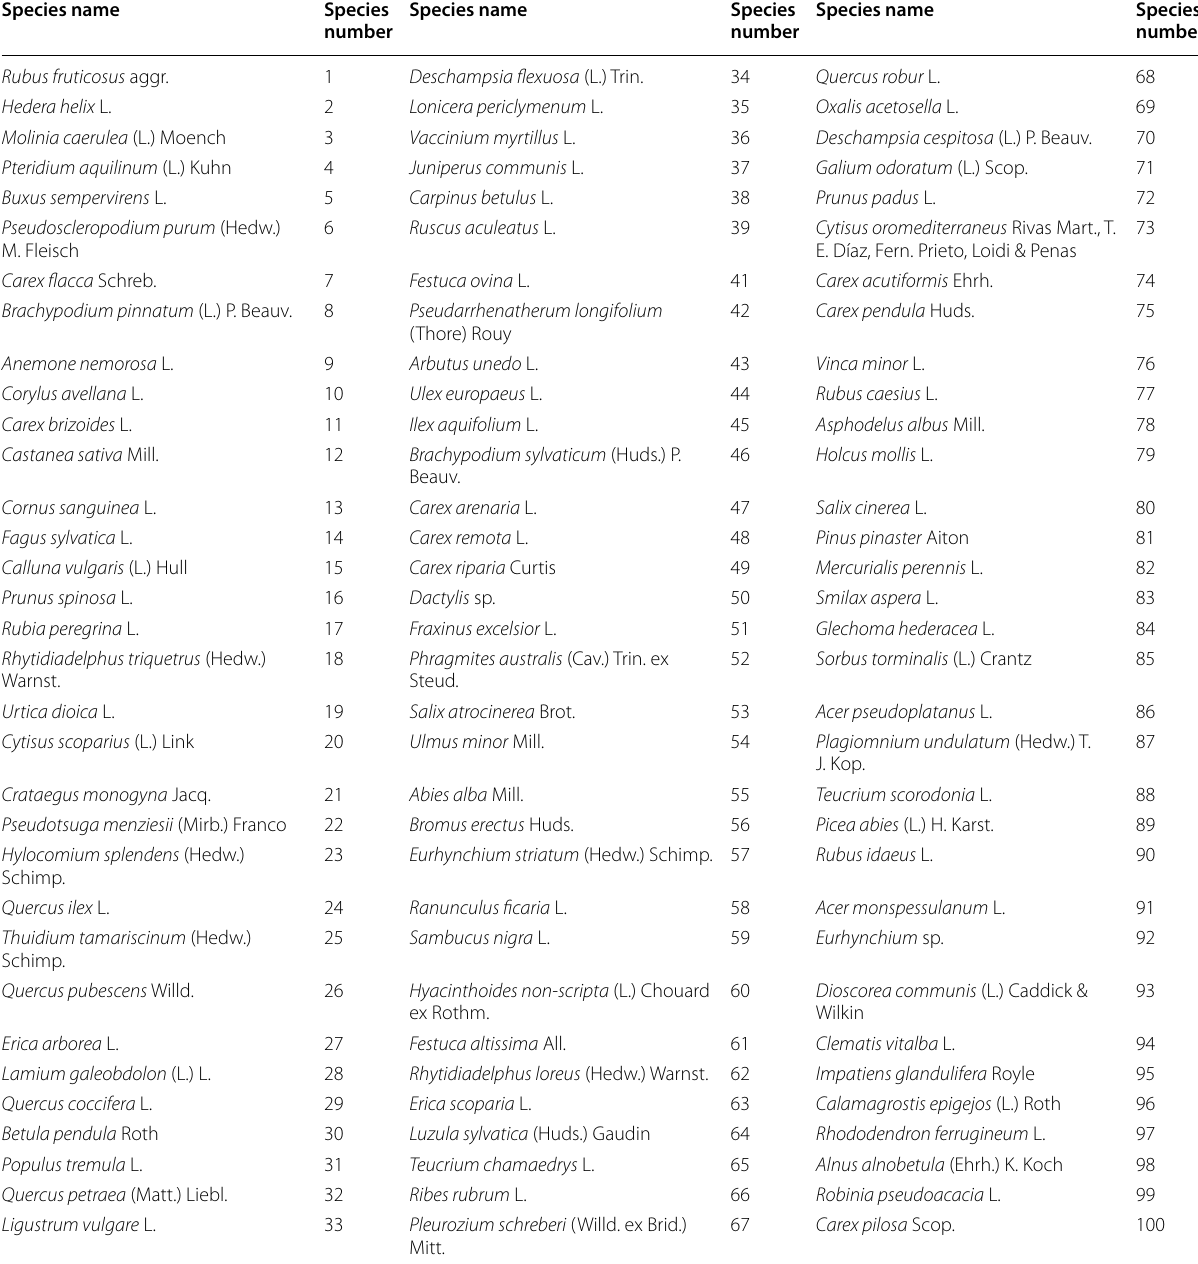
Table 4 List of the 100 species used in step 3. Species numbered 1 to 29 corresponded to the preliminary list of species used in steps 1 and 2. Species 1–29 and species 30–100 were ordered by decreasing frequency in plots where the species is present with a high cover according to NFI